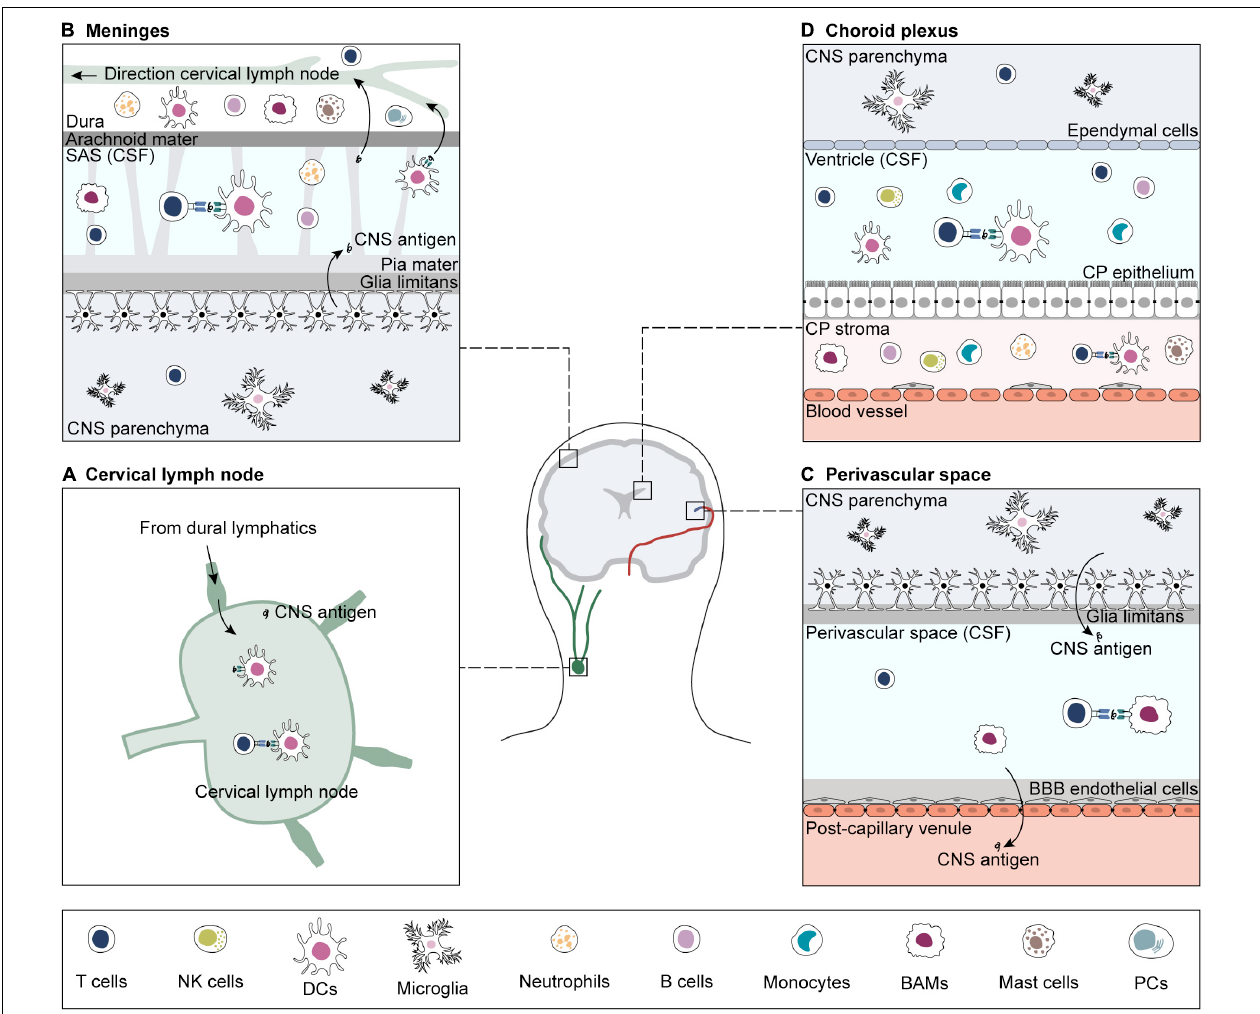
FIGURE 1 | Sites of antigen presentation of CNS-derived epitopes. CNS-derived antigens from the brain parenchyma drain to deep cervical lymph nodes and prime matching T cells (A) . For reactivation, CNS-reactive T cells extravasate from blood vessels in search for their cognate antigen on APCs in sub-arachnoid space (SAS) (B) , perivascular space (C) and choroid plexus (CP) (D) (Greter et al., 2005; Bartholomäus et al., 2009; Reboldi et al., 2009; Schläger et al., 2016; Mundt et al., 2019b; Rustenhoven et al., 2021). If re-activation is successful, CNS-reactive T cells infiltrate the brain parenchyma. CNS borders are inhabited by a variety of immune cells, including T and B cells, B plasma cells (PCs), NK cells, border-associated macrophages (BAMs), dendritic cells (DCs), monocytes, and granulocytes (neutrophils and mast cells) (Goldmann et al., 2016; Jordão et al., 2019; Mundt et al., 2019b; Van Hove et al., 2019; Fitzpatrick et al., 2020; Schafflick et al., 2020, 2021; Brioschi et al., 2021; Dani et al., 2021; Rustenhoven et al., 2021). The brain parenchyma contains microglia and small numbers of memory T cells (Smolders et al., 2013, 2018; Herich et al., 2019; Pasciuto et al.,